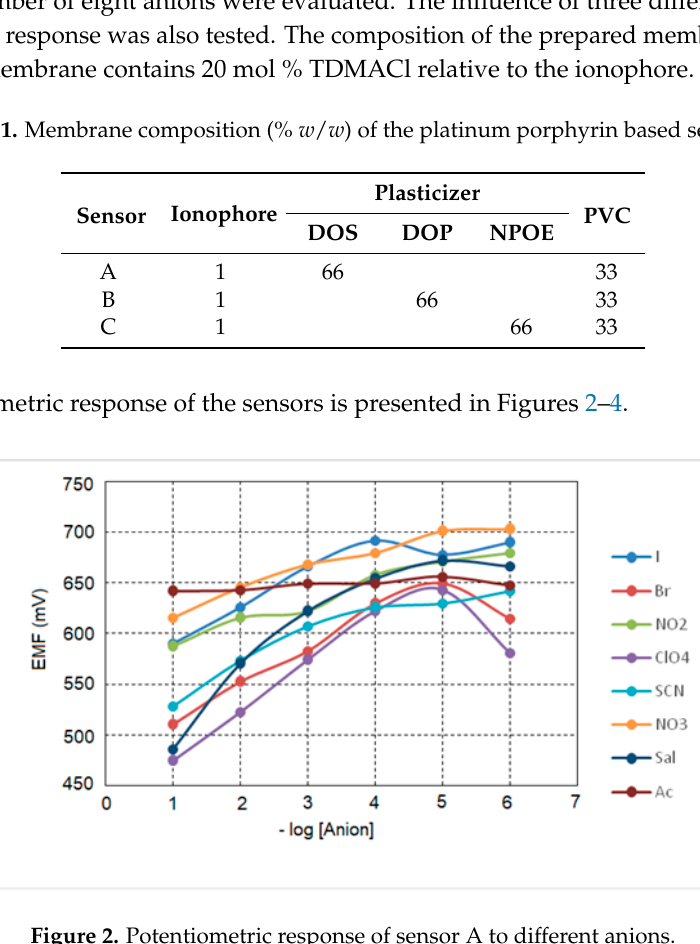
Figure 2. Potentiometric response of sensor A to different anions.